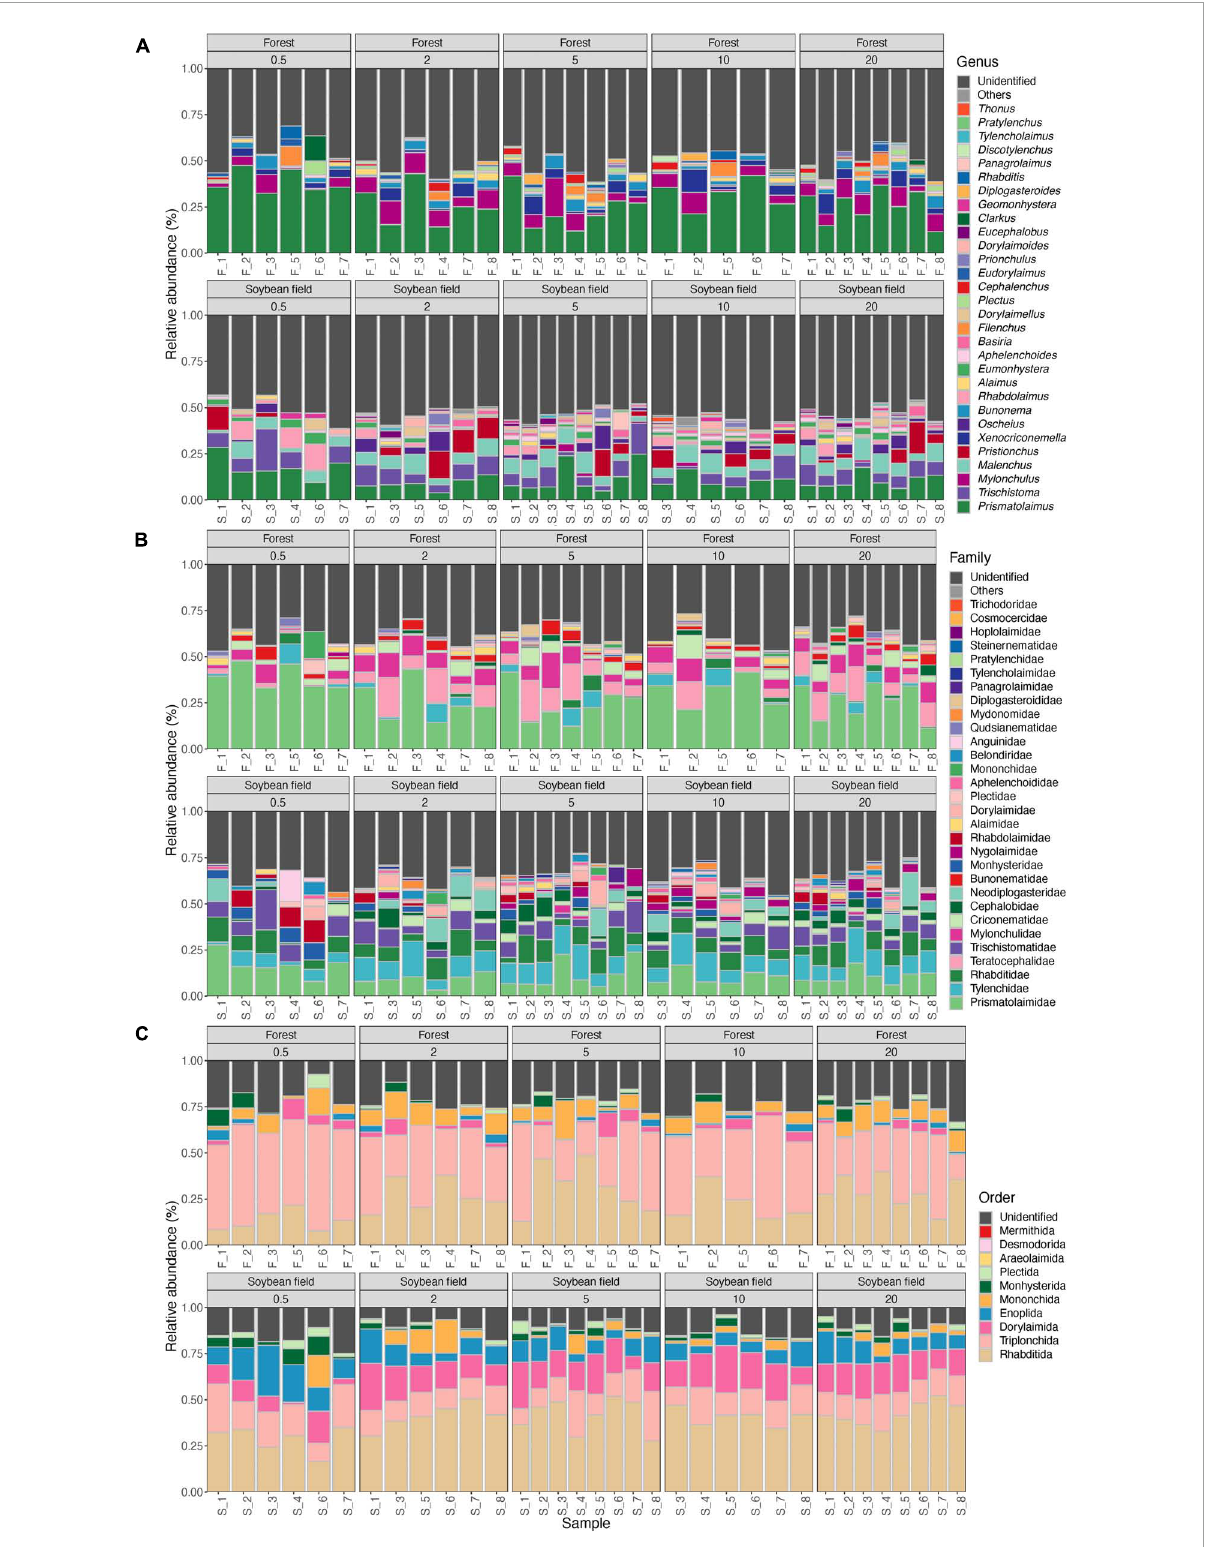
FIGURE4 Community compositions of nematodes at the genus (A) , family (B) , and order (C) levels. The alphabets indicating source ecosystem type (“F_,” forest; “S_,” soybean field) are followed by replicate sample numbers. Samples with less than 1,000 sequencing reads were omitted.